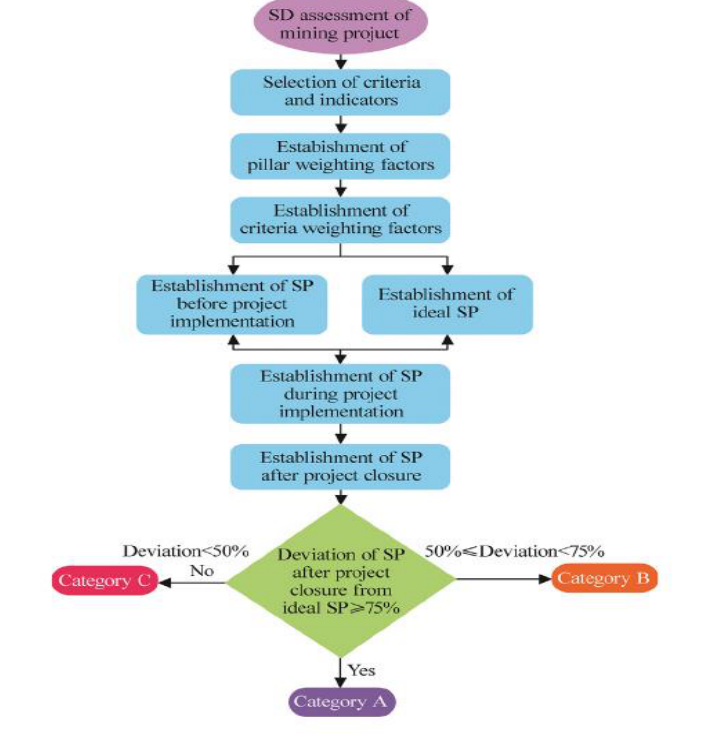
Fig. 2: ‘‘Go-No-Go” decision making process for project assessment from the sustainable development point of view; Source : Adopted from Kamenopoulos, S. et al.,